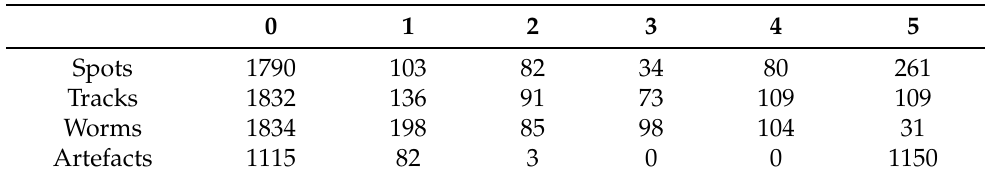
Table 1. Distribution of votes for the certain class in the data set. Columns represent number of voices and rows represent certain classes. A judge could skip voting for a certain image if they were unsure as to which class it should be